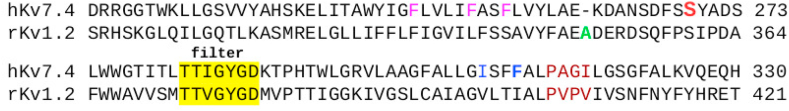
The pore domain sequence alignment of hKv7.4 and rKv1.2. Conserved PVPV motif in Kv1.x channels and its corresponding PAGI motif in Kv7.x are highlighted in brown color. The missing residue in the sequence alignment is shown in green color.